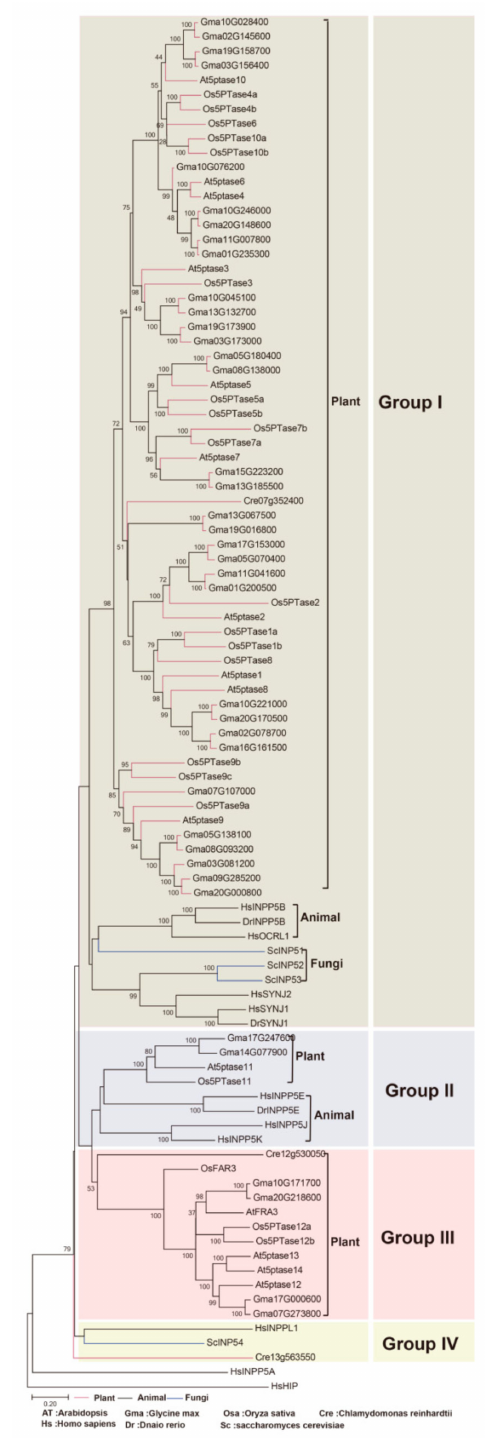
Figure 3. Phylogeny of representative 5PTase genes from plants, animals, and fungi. Tree topology generated via maximum-likelihood (ML) using MAFFT (MSA tool that uses Fast Fourier Transforms) alignment is shown here. The protein sequences containing the conserved 5PTase domain were used for the alignment. At, Arabidopsis ; Os, rice; Pp, Physcomitrella patens ; Cre, Chlamydomonas reinhardtii ; Hs, Homo sapiens ; Dr, Danio rerio ; Ce, Caenorhabditis elegans ; Sc, Saccharomyces